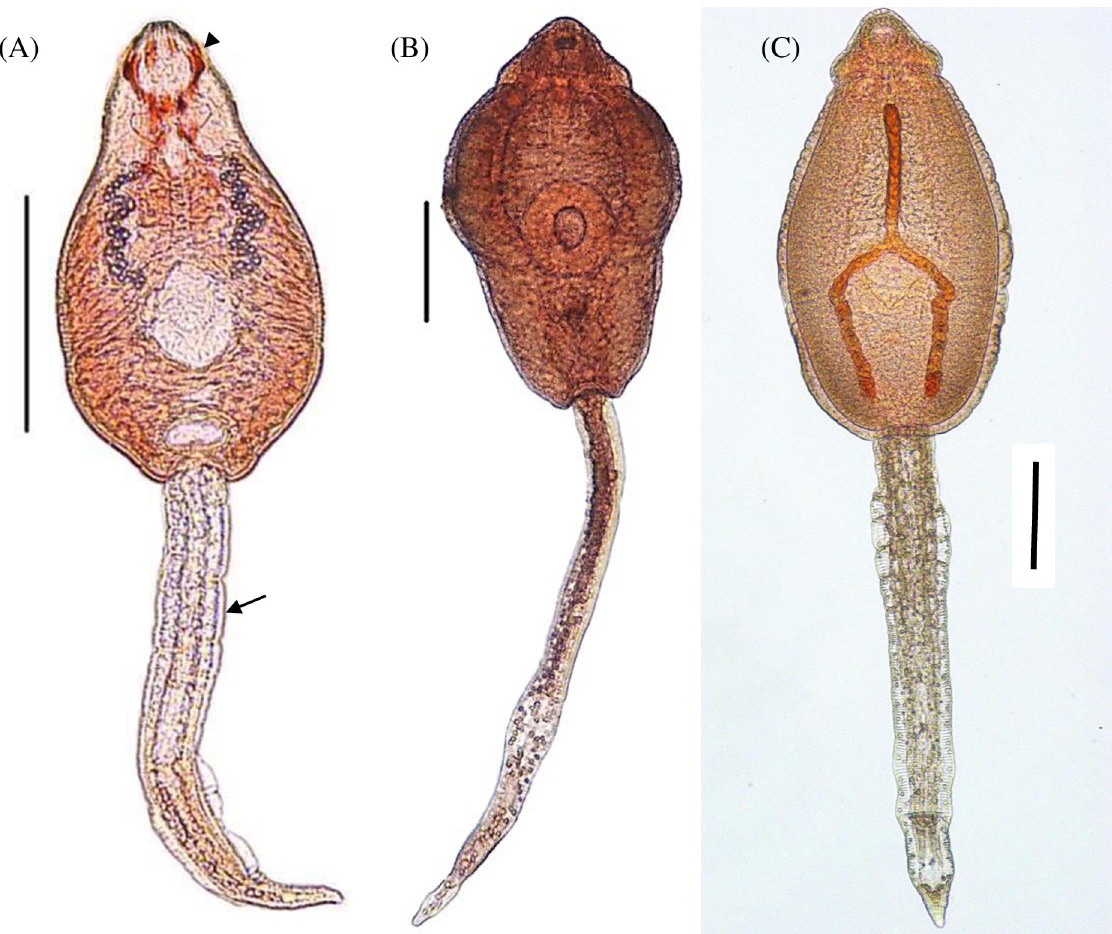
Fig 1. Photomicrographs of echinostomatid cercariae. (A) Echinostoma revolutum ( s . s .) stained with neutral red to show outlets of paraoesophageal gland cells (arrowhead) and one of seven tegumental finfolds (arrow), scale-bar: 200 μ m. (B) Echinoparyphium recurvatum and (C) Echinoparyphium aconiatum stained with acetocarmine, scale-bars: 100 μ m. clades corresponding to E . revolutum ( s . s .), Ep . aconiatum , Ep . recurvatum and H . conoideum in ML phylogenetic trees (Fig 2). Hypoderaeum conoideum phylogenetically nested within the Echinoparyphium clade. Echinostoma revolutum separated into two sub-clades, E . revolutum ( s . s ). Eurasia and E . revolutum of Detwiler et al. [2010] USA. K / θ � 4 confirmed Eurasian E . revolutum ( s . s ) as a genetically separate species from USA E . revolutum (Table 2). USA E . revo- lutum sequences were, therefore, excluded from molecular diversity analyses. Echinostomatids infected 8.1% (81/995) of sampled snails. The 81 cox 1 sequences clustered into four strongly supported clades for Ampullaceana balthica (junior synonyms Lymnaea per- egra , Radix balthica , Radix ovata ; https://www.molluscabase.org), Radix auricularia , Lymnaea stagnalis and a mixed cluster of Stagnicola fuscus + Stagnicola palustris (S1 Table, S1 Fig). The cox 1 sequencing did not permit genetic differentiation of Stagnicola snails in this study, which are, therefore, referred to as Stagnicola sp. Molecular identification of snails was not always congruent with morphological identification due to phenotypic overlap of shell morphology between some specimens of A . balthica and R . auricularia . Echinostoma revolutum ( s . s .) infected all four species of snails identified. Echinoparyphium aconiatum was hosted by three